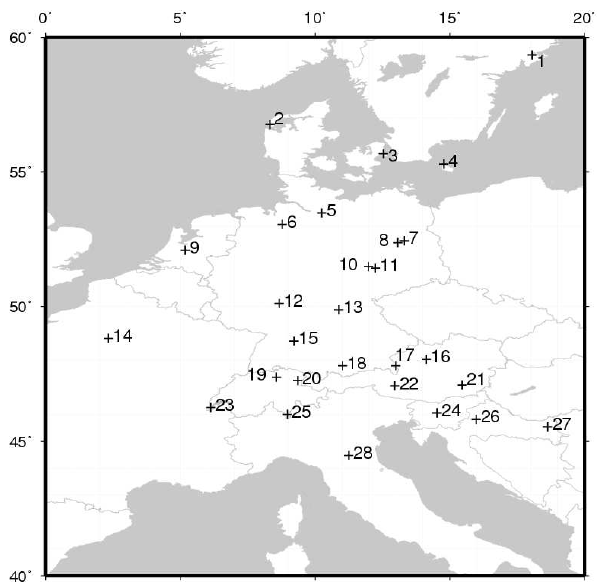
Fig. 1. Map of the stations used in the analysis. The station numbers are as in Table 1.